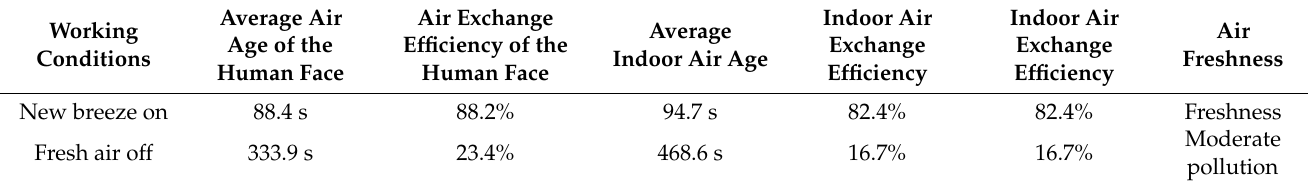
Table 3. Comparison of air quality indicators for the human face and indoor